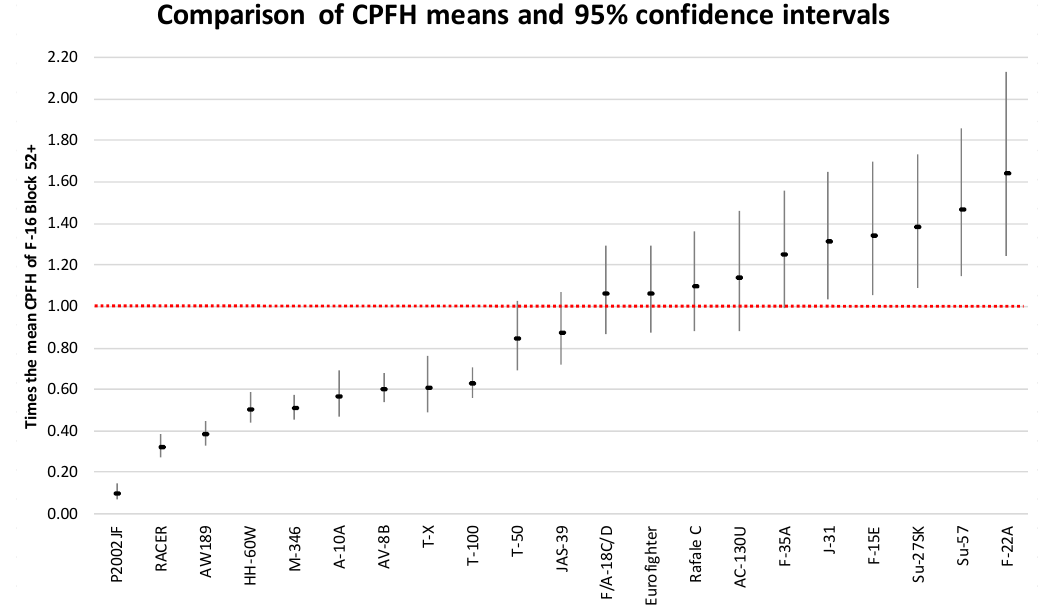
Figure 10. A comparative application of mean CPFH predictions with 95% CI for a set of ‘unknown’ aircraft types. Table 7. A comparative application of mean CPFH predictions with 95% CI for a set of ‘unknown’ aircraft types. The figures indicate ‘times the mean CPFH of F-16 Block 52+.’